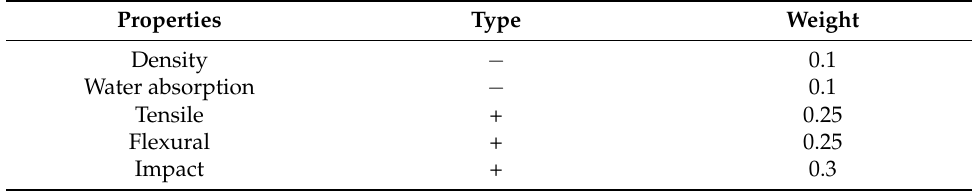
Table 3. Characteristics of